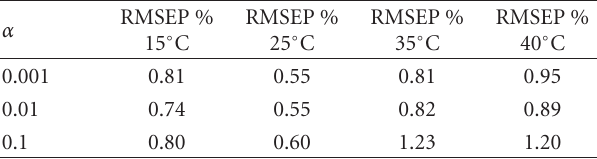
Figure 8: The prediction error for validation sets at various temperatures by using GLSW filter. B: validation set at 15 ◦ C; C: validation set at 25 ◦ C; D: validation set at 35 ◦ C; E: validation set at 40 ◦